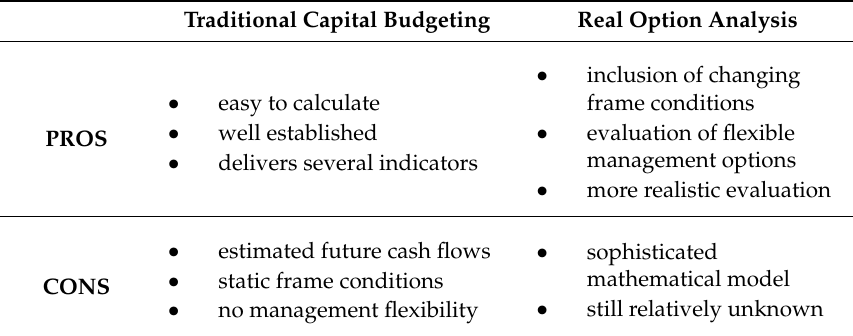
Table 3. Capital budgeting vs. real option. Some works recognize the potential of real options approaches for the maritime